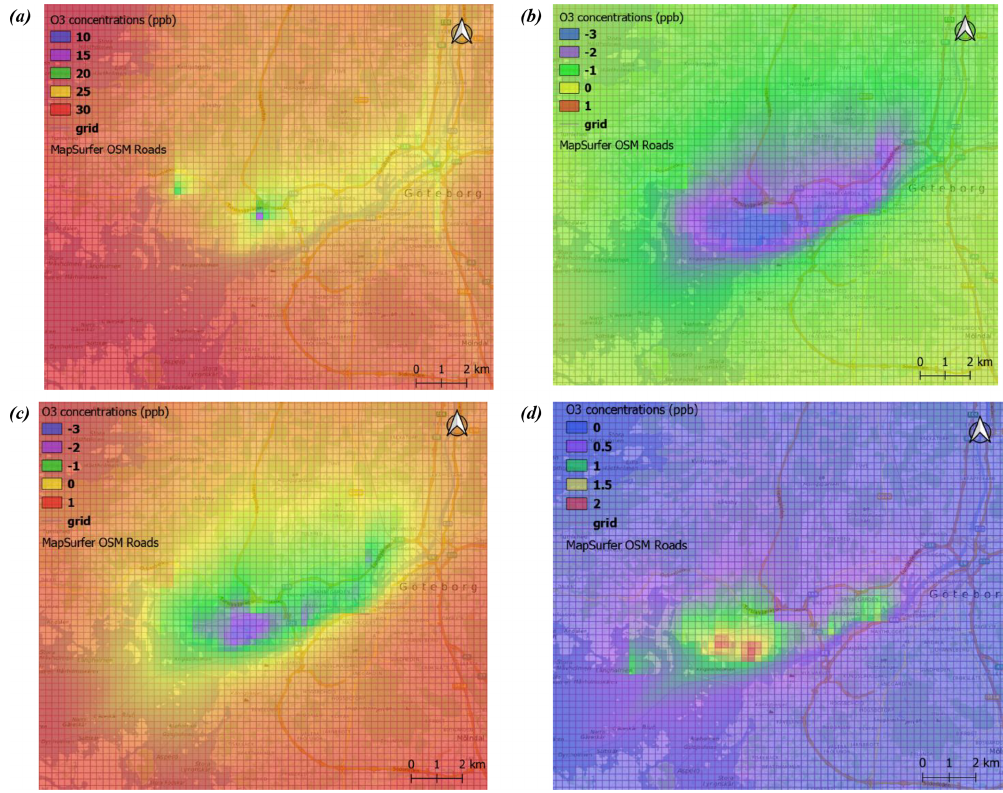
Figure 9. Modelled summer mean (JJA) ozone concentrations (ppb) in the year 2012 and contributions of local and regional shipping: (a) modelled O 3 concentrations in the Base model simulation, (b) modelled contribution of emissions from local shipping, (c) modelled contribution of emissions from local and regional shipping and (d) modelled contributions of NMVOC emissions from local shipping.